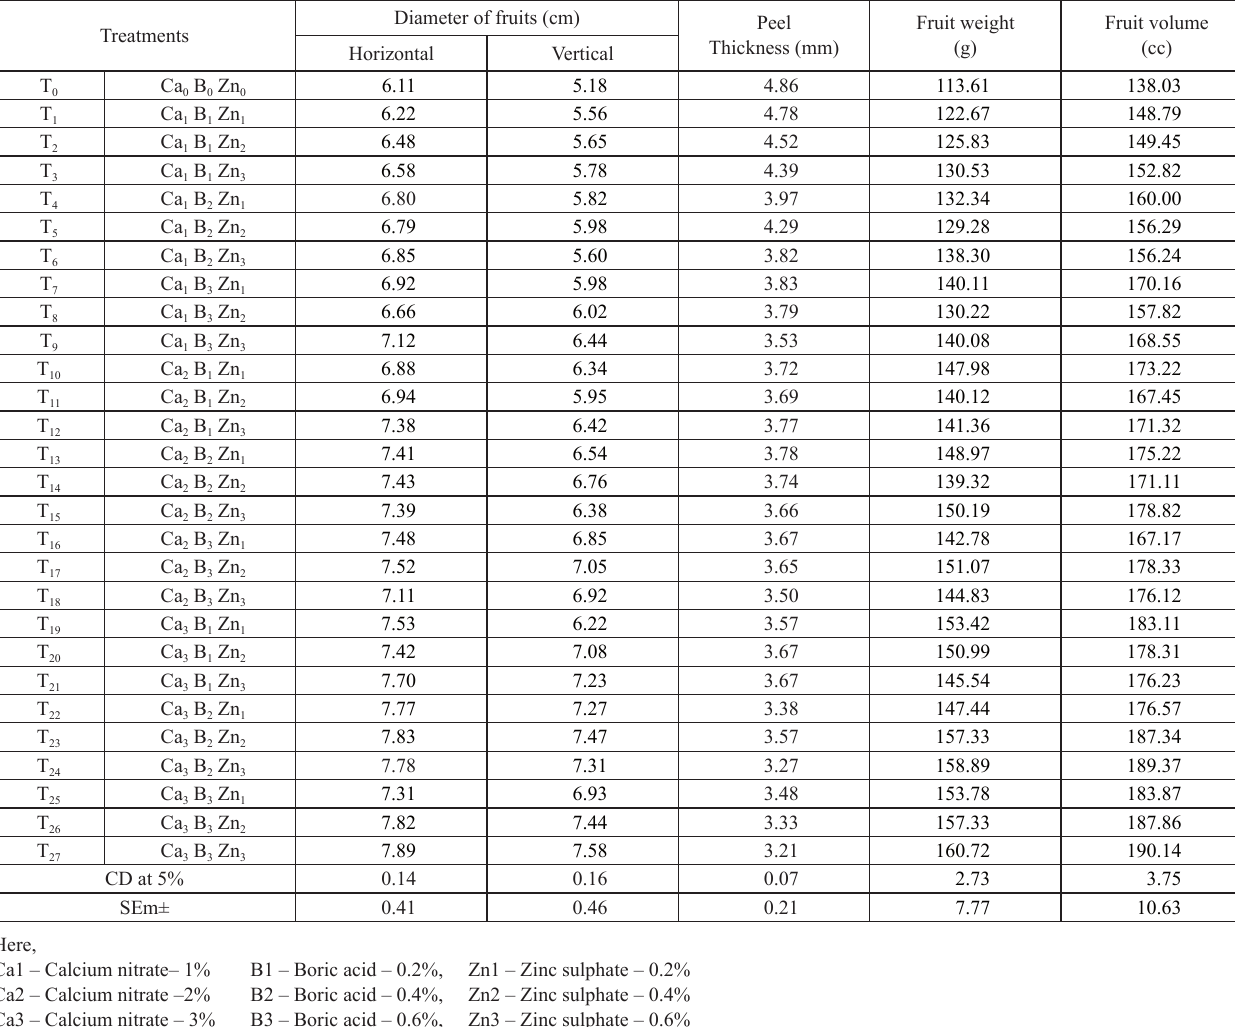
Table: 1 Effect of pre-harvest spray of calcium nitrate, boric acid and zinc sulphate on physical characteristics of Nagpur mandarin ( Citrus reticulata Blanco)